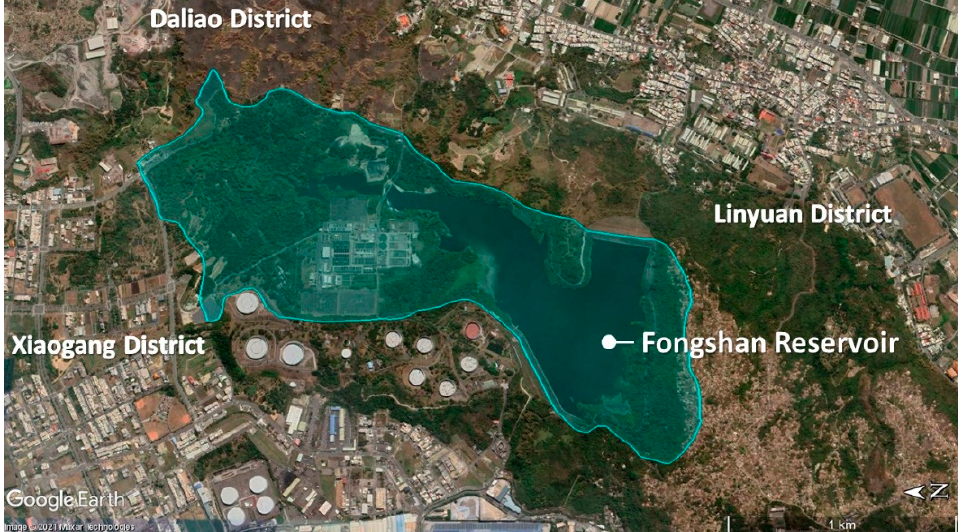
Figure 2. Location of Mingde Reservoir (including water catchment area).